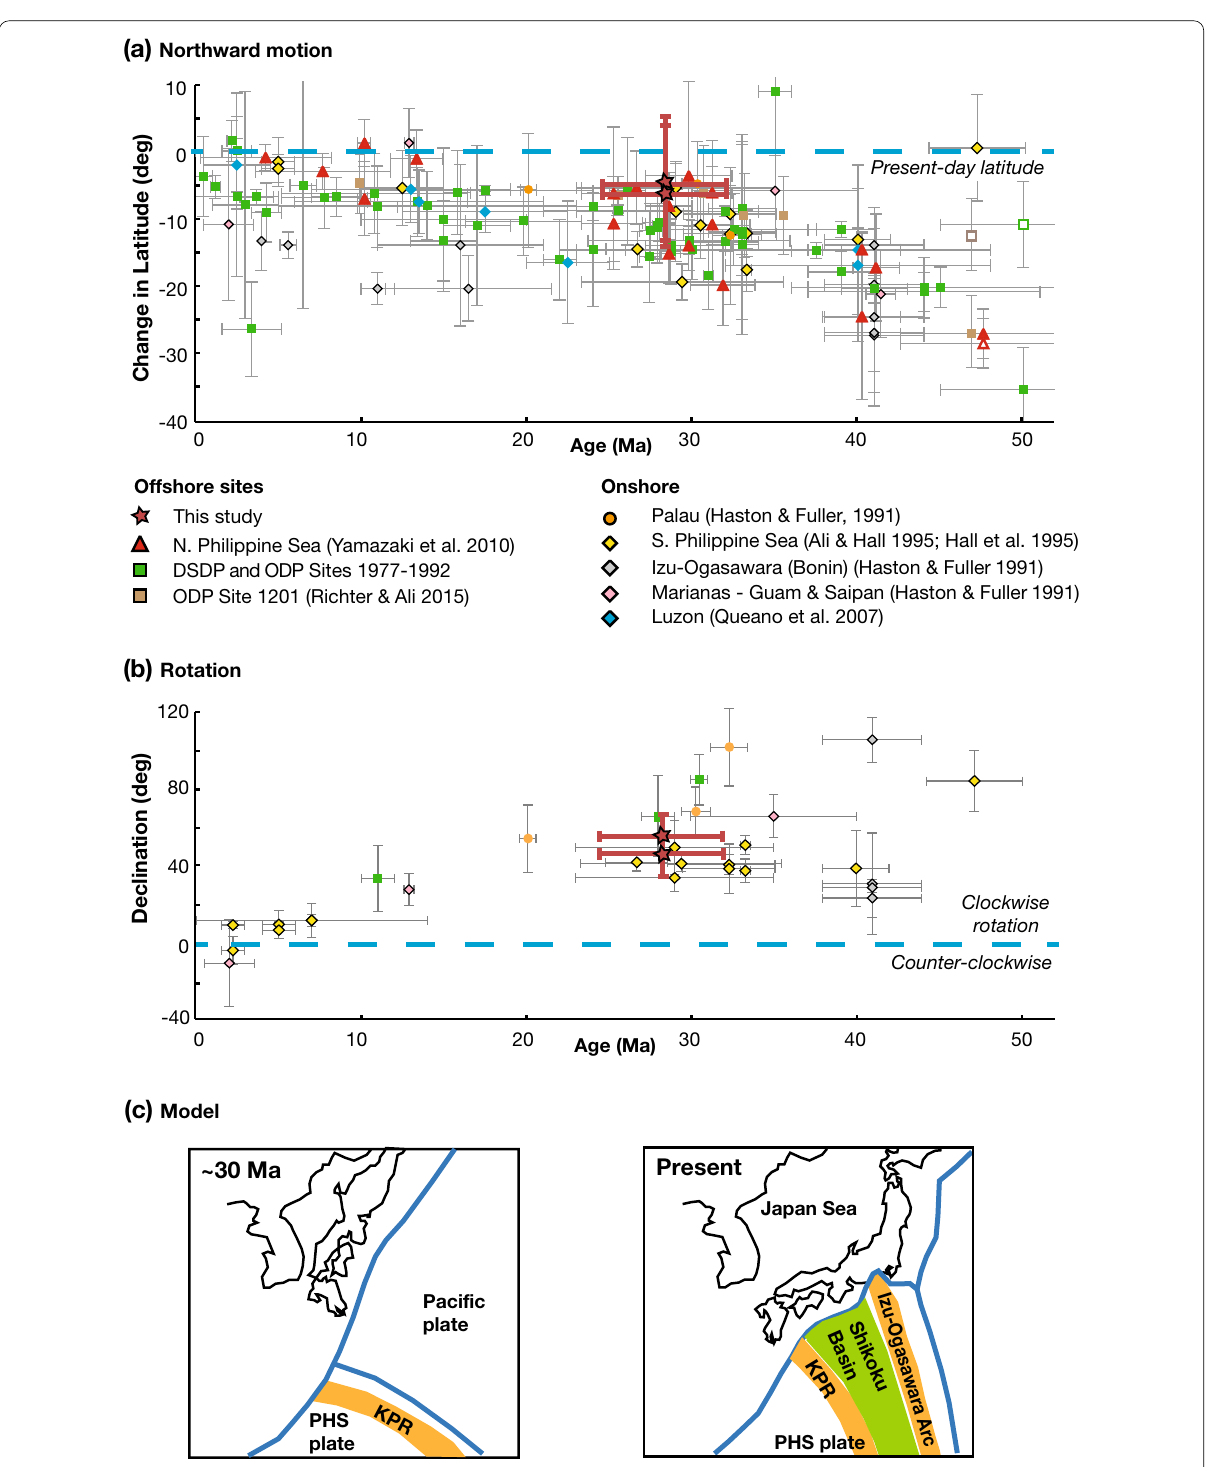
Fig. 5 Latitudinal change ( a ) and rotation ( b ) of the Philippine Sea plate with age compiled from published studies (Wu et al. 2016, Fig. 3) and the present study (red star). References for DSDP and ODP Sites in 1977–1992 are Louden (1977), Kinoshita (1980), Keating and Herrero (1980), Keating (1980), Bleil (1982), Haston et al. (1992), and Koyama et al. (1992). c Schematic model of the Kyushu-Palau ridge (KPR) location at ~ 30 Ma (left) and the present positions of KPR and Izu-Ogasawara (Bonin) arc